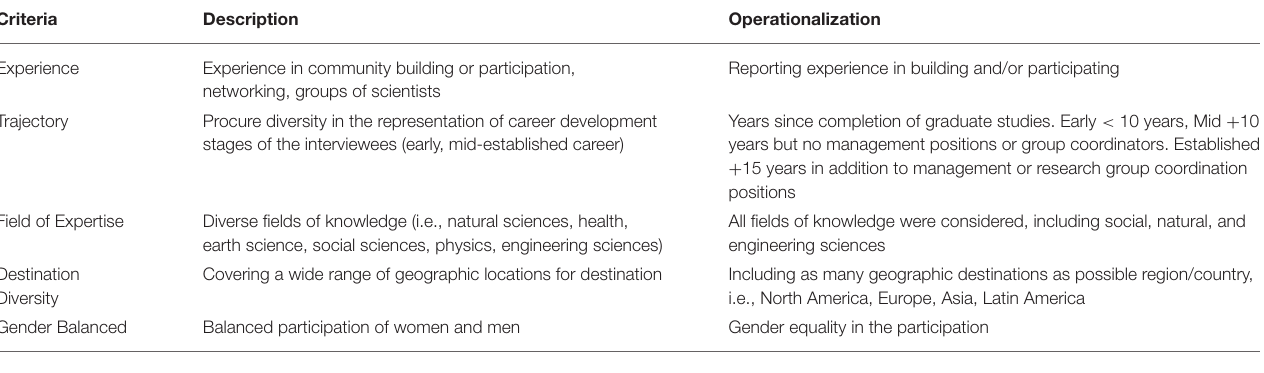
TABLE 1 | Criteria—selection of key respondents of semi-structured interviews scientific community. Criteria